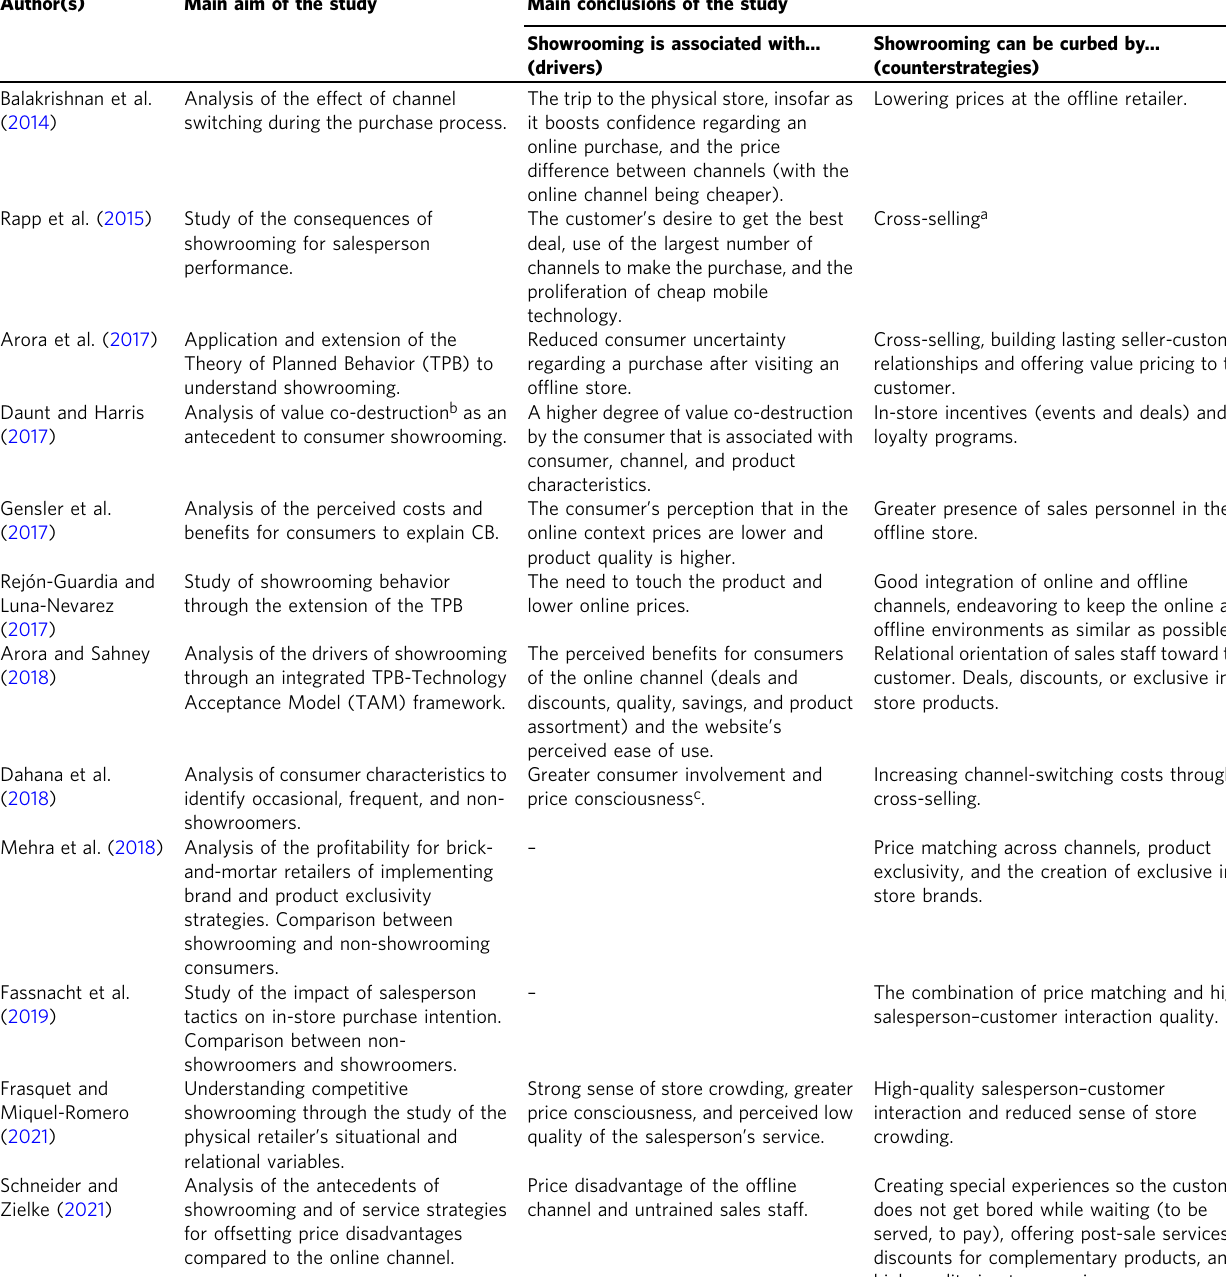
Table 1 Studies on retailer switching during the purchase process and conclusions regarding